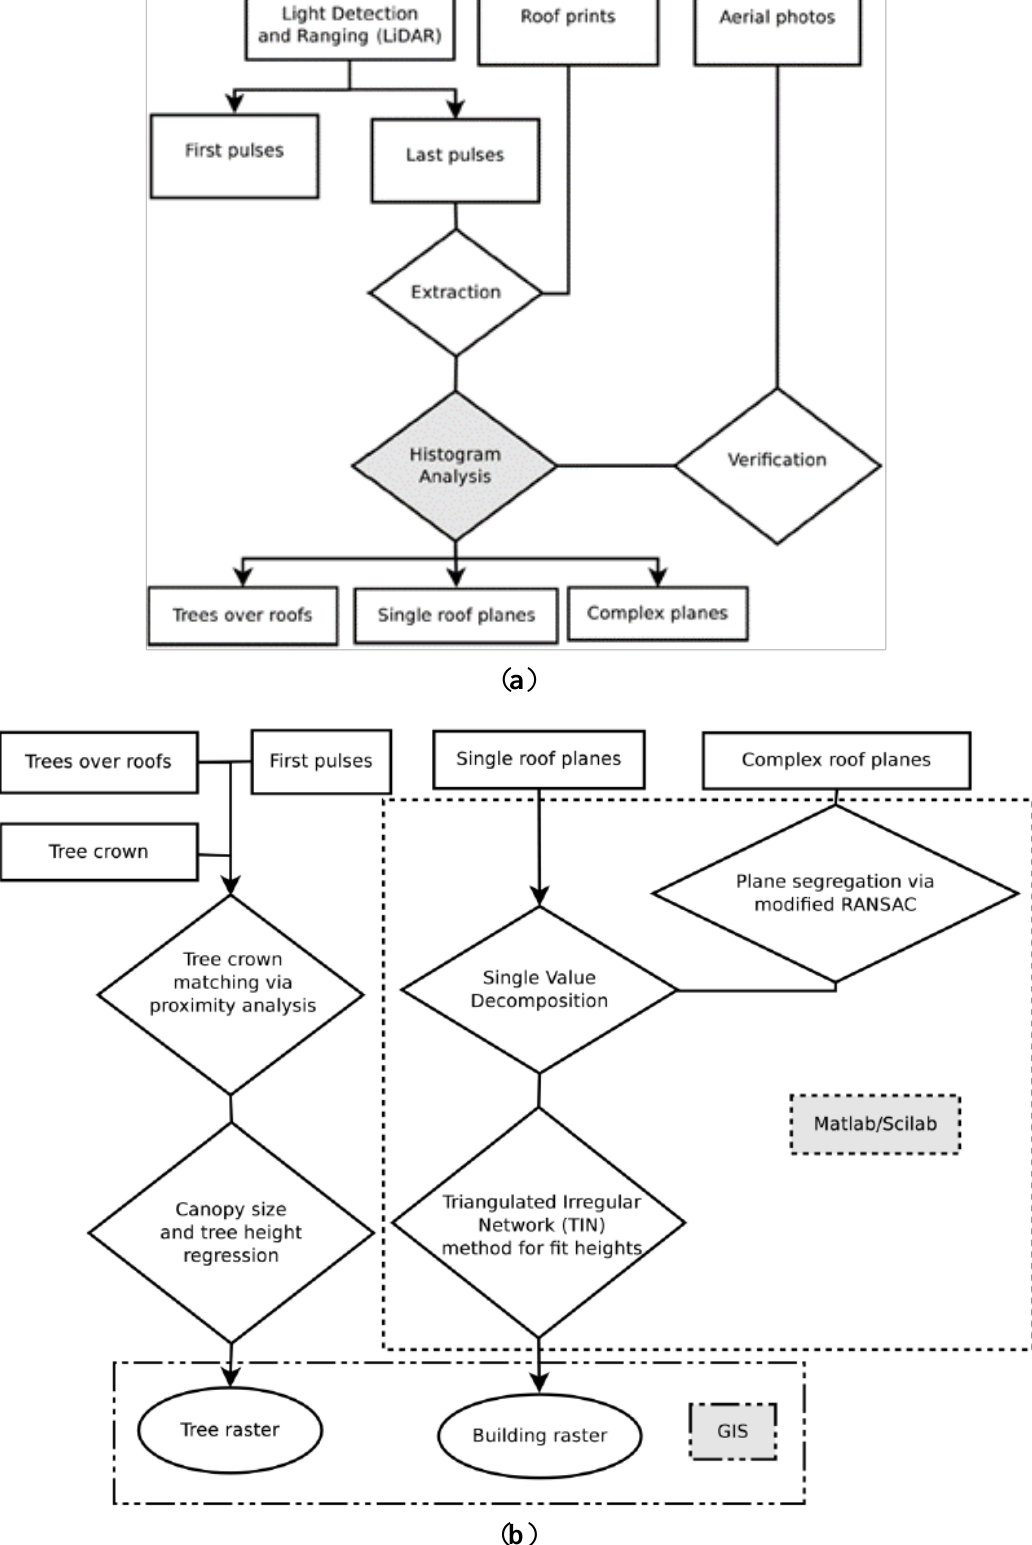
Figure 2. ( a ) Workflow part a. The classification of points based on the objects they correspond to was carried out in ArcGIS; ( b ) Workflow part b. Roof segregation was done using Matlab, followed by the interpolation and rasterization in ArcGIS; ( c ) Workflow part c. Final scene construction (in ArcGIS) and irradiance modeling (in